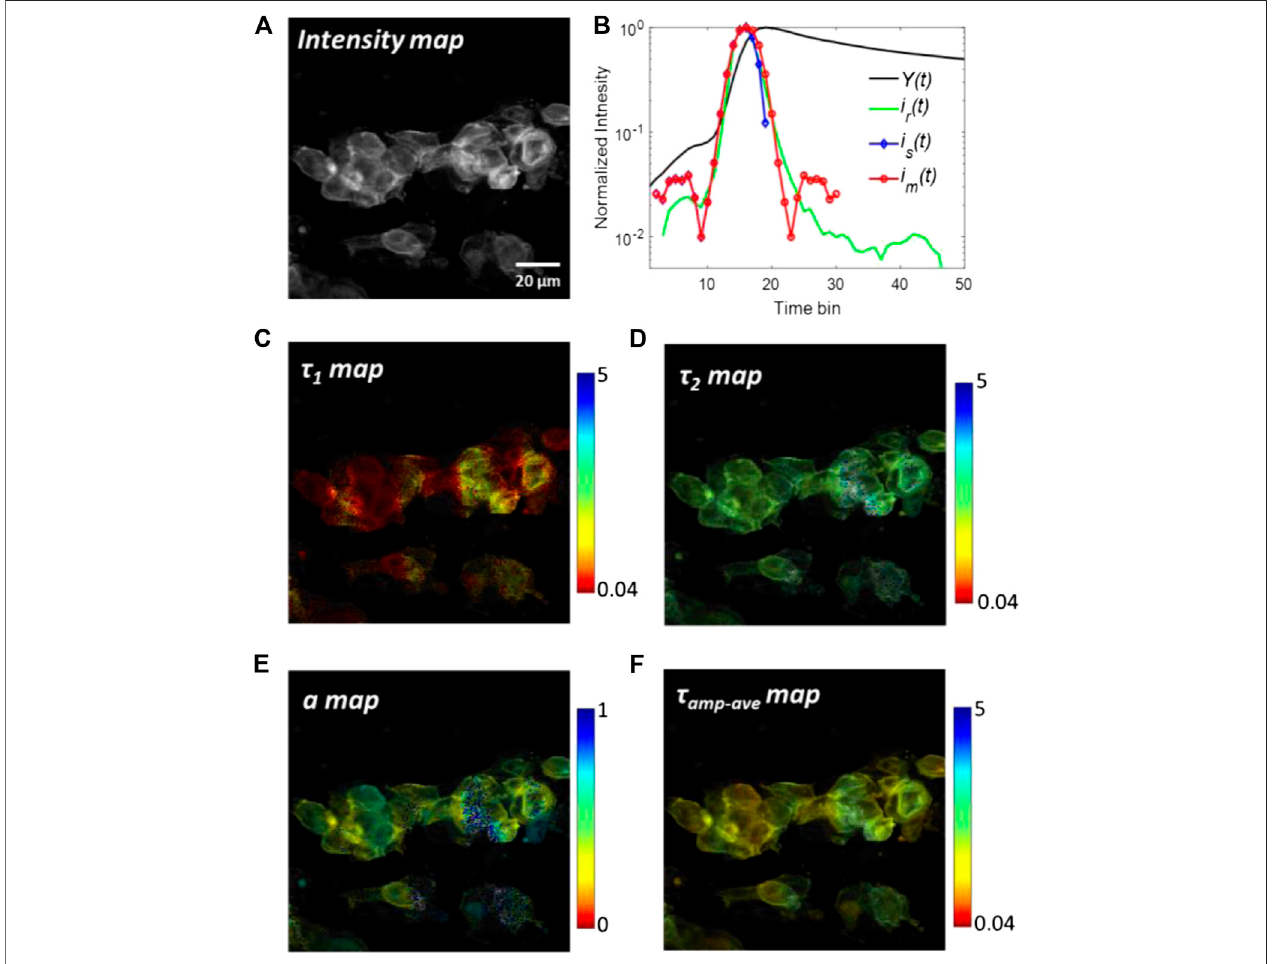
FIGURE 6 | Analyzed results of tSA201 cells with co-transfected eYFP. (A) Grey-scale fl uorescence intensity image. (B) Measured IRF, i r (t) , and the summed histogram, Y(t) ,areplottedwithagreenandblacksolidline,respectively. i r (t) and i m (t) areshownindashlineswithmarkers. (C – F) τ 1 , τ 2 , a, and τ amp-ave imagesusingthe experimental IRF ( i r (t) ) and constrained LSD-LE method with ( α , L ) (cid:2)